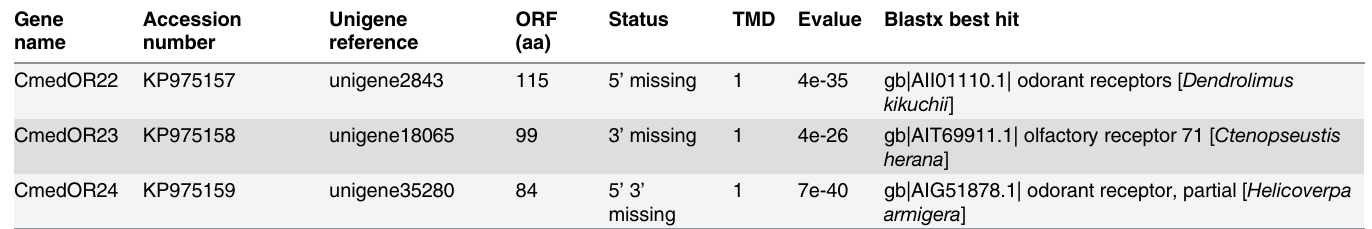
Table 3. Unigenes of candidates for olfactory receptors.